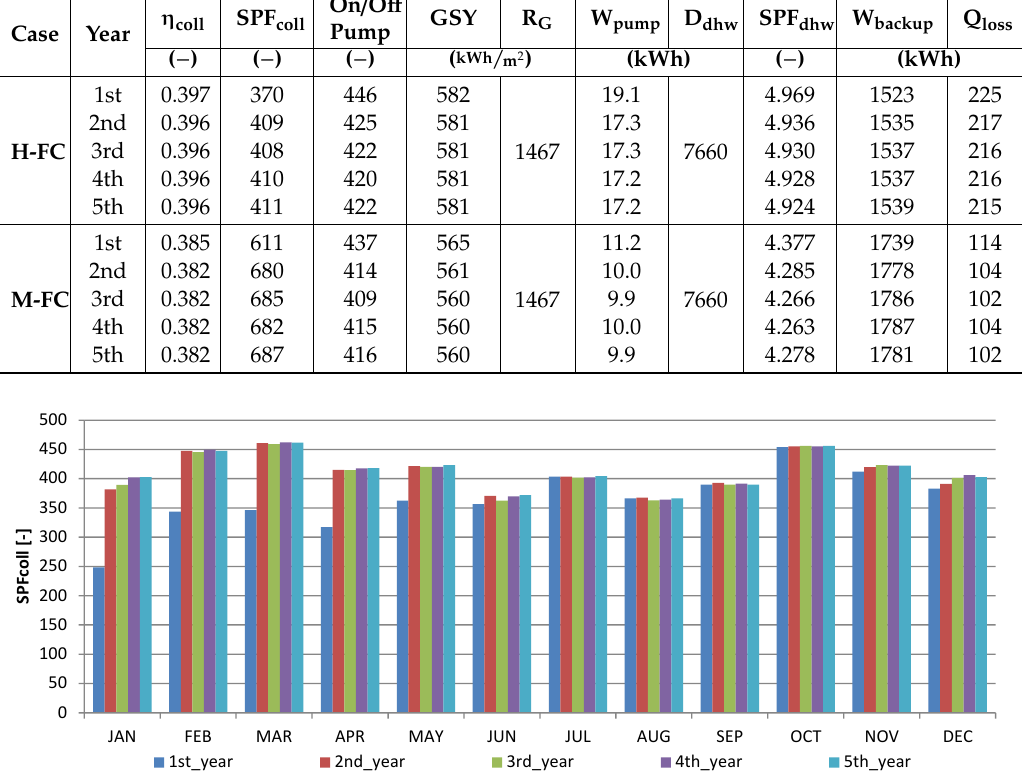
Table 6. Q-learning applied to the H- and M-FCs.